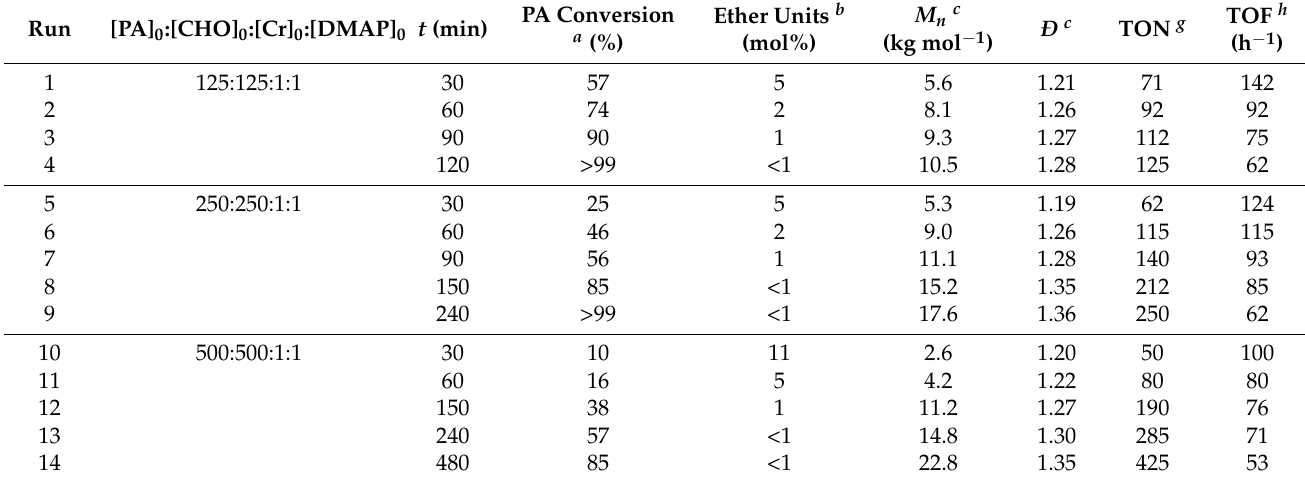
Table 3. Effects of PA:CHO: 3a :DMAP ratios on the ROCOP of PA and CHO.